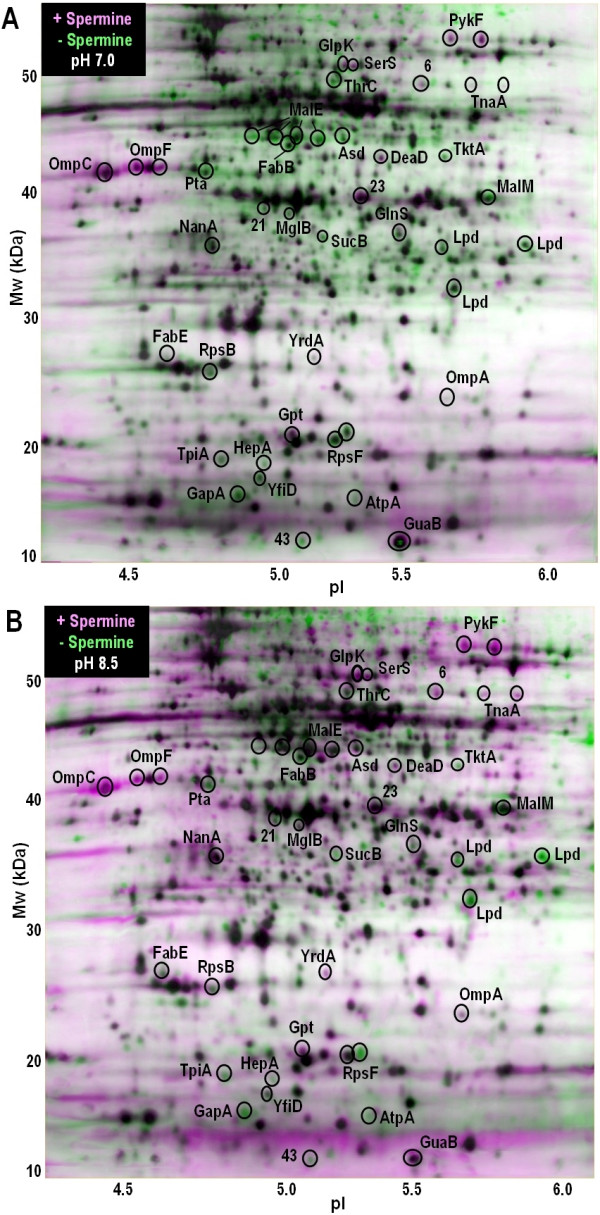
Protein profiles in the presence or absence of 1 mM spermine. The horizontal axis represents the approximate pH range of the isoelectric focusing first dimension, and the vertical axis represents the molecular weight (Mw). The "layered view" superimposes two composite images, each composed from three 2-D gels of independently grown replicate cultures. All E. coli cultures were diluted 500-fold and grown at 37°C to an OD600 of 0.2 in LBK with (pink) or without (green) 1 mM spermine. Culture media were buffered as described under Methods. (A) 100 mM MOPS, pH 7.0. (B) 100 mM TAPS, pH 8.5.